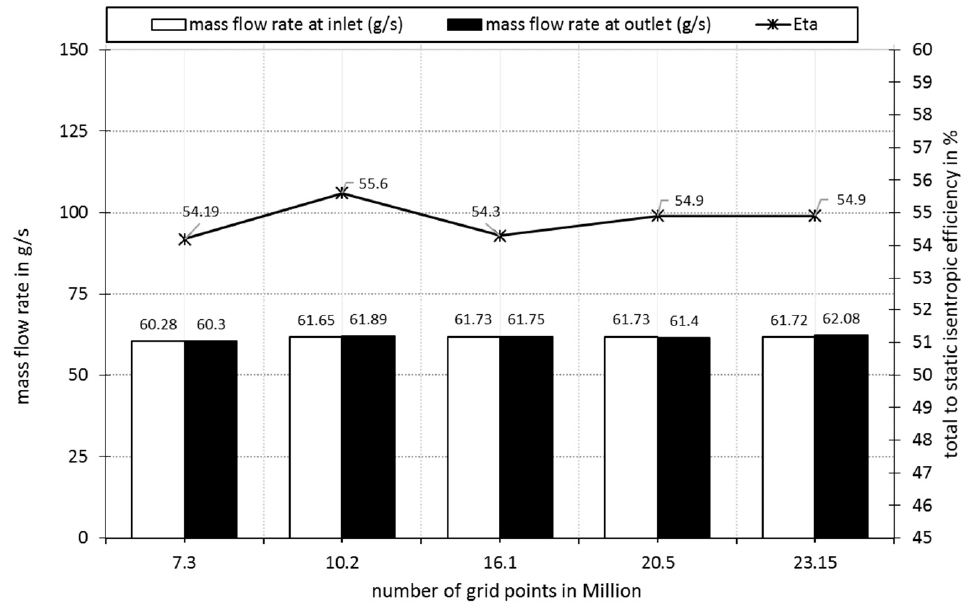
Figure 6. Mass flow rate and total-to-static isentropic efficiency as a function of the number of grid